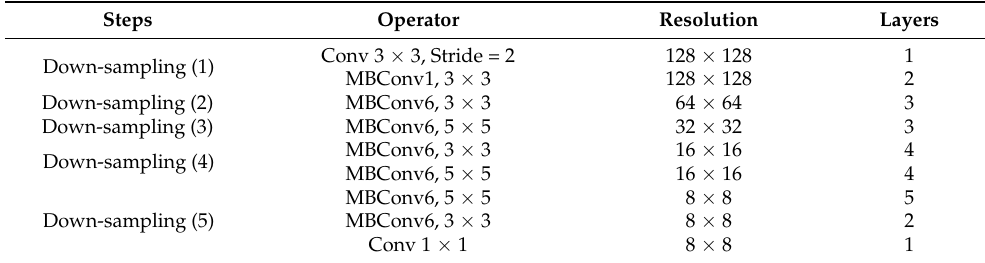
Table 1. Encoder specification for the proposed segmentation